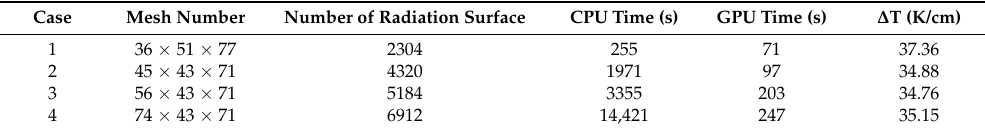
Table 2. Time consumed to solve AC = B by CPU and GPU with different mesh number.